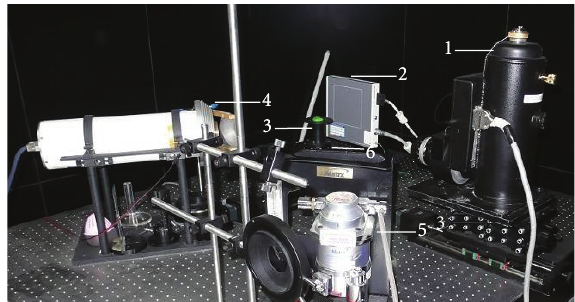
Figure 2: Our prototype BLT/Micro-CT dual modality imagingsys- tem. (1) CCD camera; (2) X-ray detector; (3) mouse holder; (4) X- ray tube; (5) anesthesia machine; (6) rotation